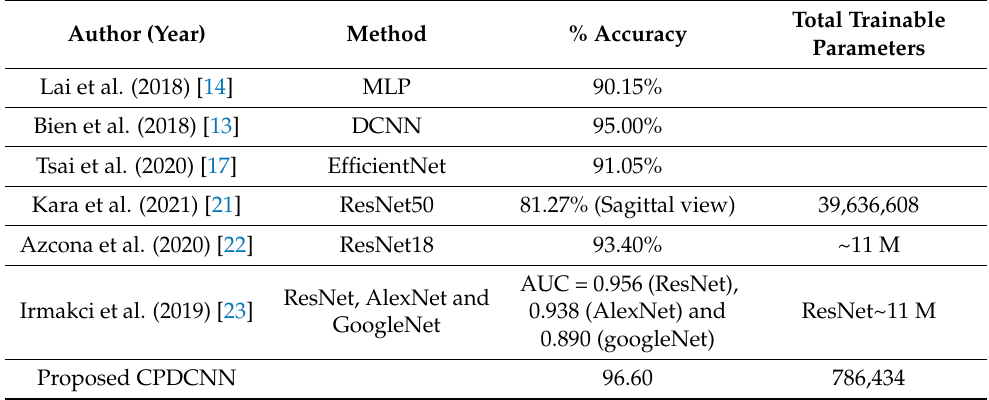
Table 3. Performance comparison of proposed system with previous ACL tear detection